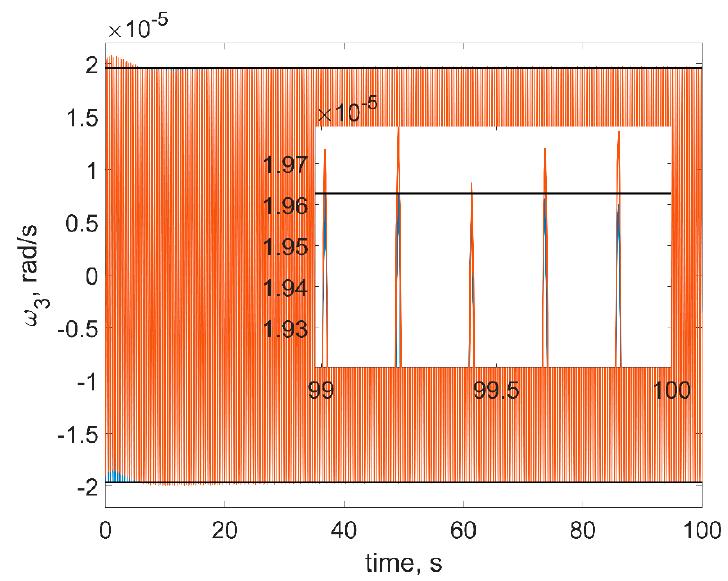
ω for static imbalance case (red is numerical solution, blue is approximate Figure 13. Evolution of Figure 13. Evolution of ω 3 for static imbalance case (red is numerical solution, blue is approximate 3 solution, horizontal lines are the estimations). solution, horizontal lines are the